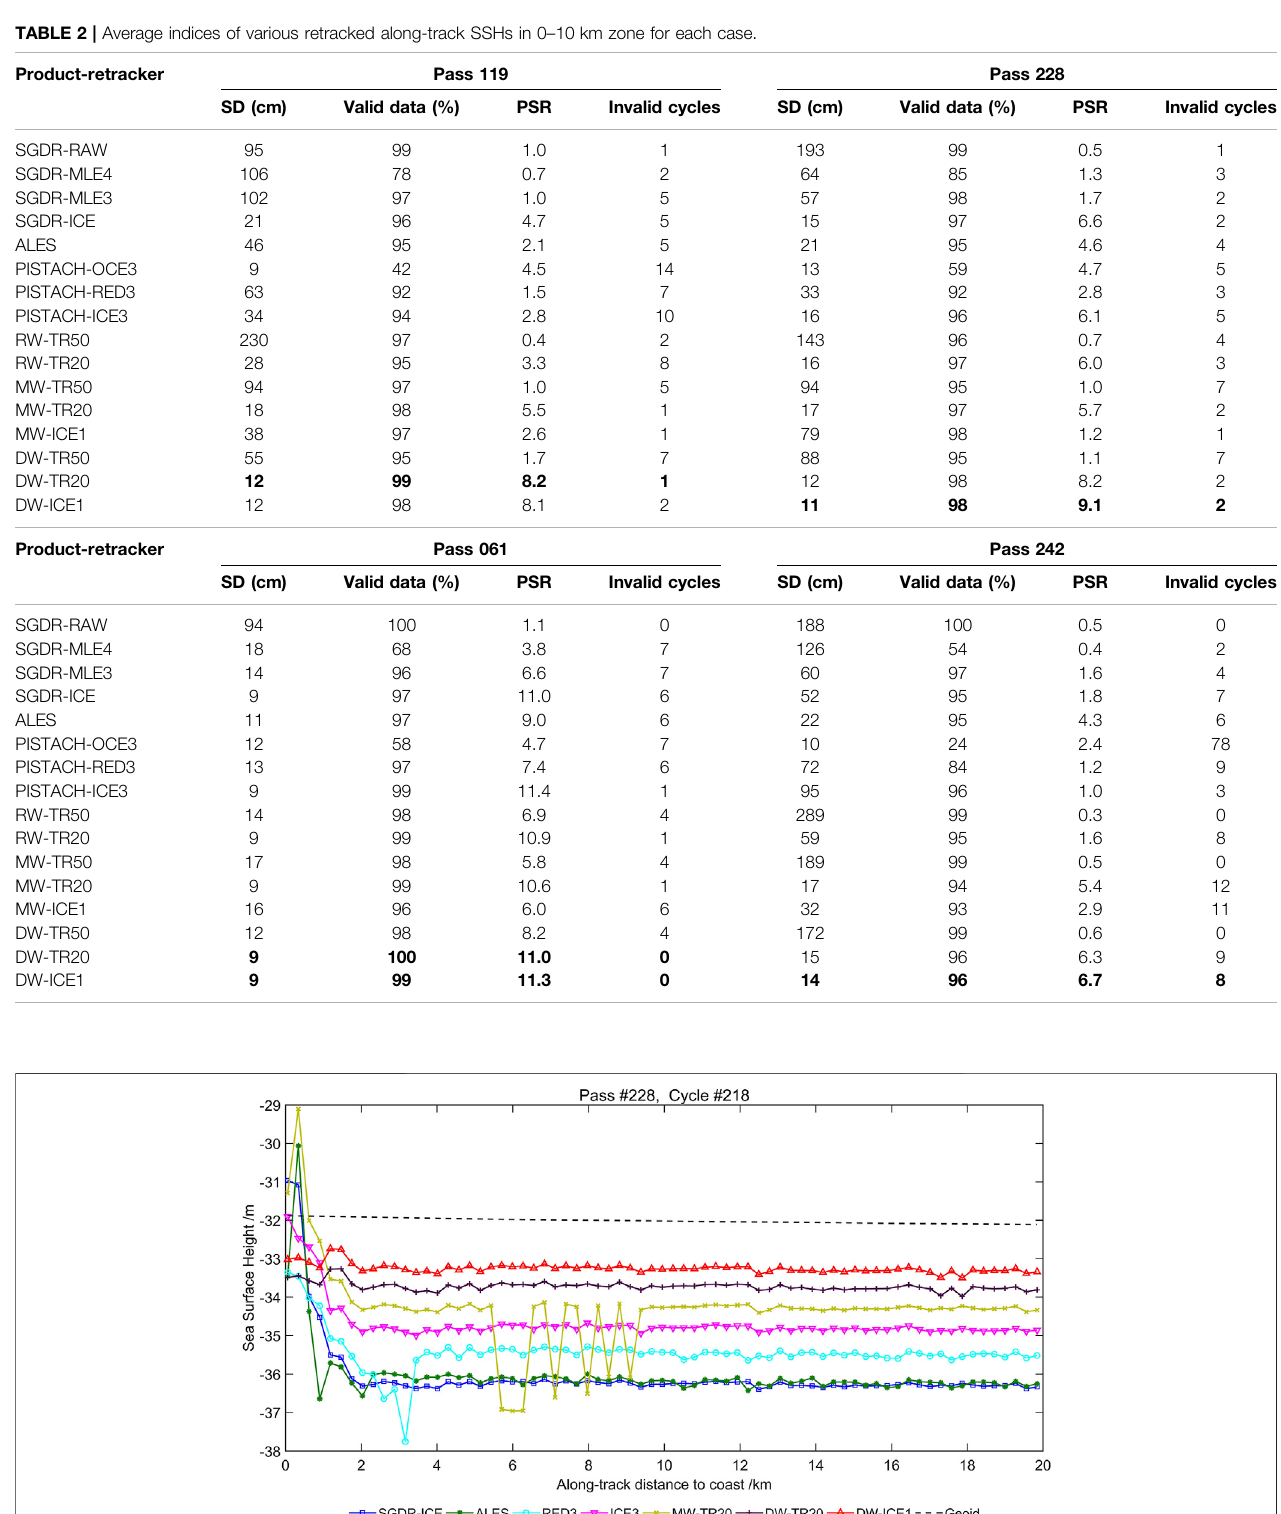
TABLE 2 | Average indices of various retracked along-track SSHs in 0 – 10 km zone for each case. Product-retracker